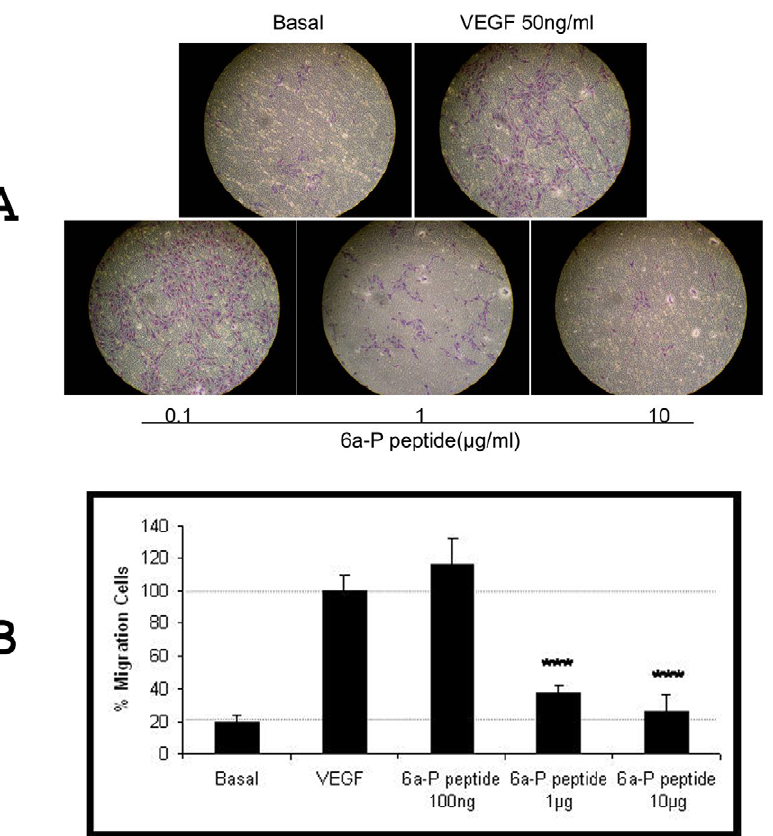
Figure 3. 6a-P peptide inhibits endothelial cells migration. HUVECs were plated into inserts (8 m m pore size) of 24-well transwell plate and duplicated. The lower chamber was filled with serum free EBM medium containing 50 ng/ml rhVEGF plus different concentrations of the peptide for 16 h. The results show that endothelial cells migrating across the membrane are suppressed by the peptide in dose-dependent manner (A). VEGF induces endothelial cell migration is inhibited almost 90% when peptide is present at high concentration (B; P ,